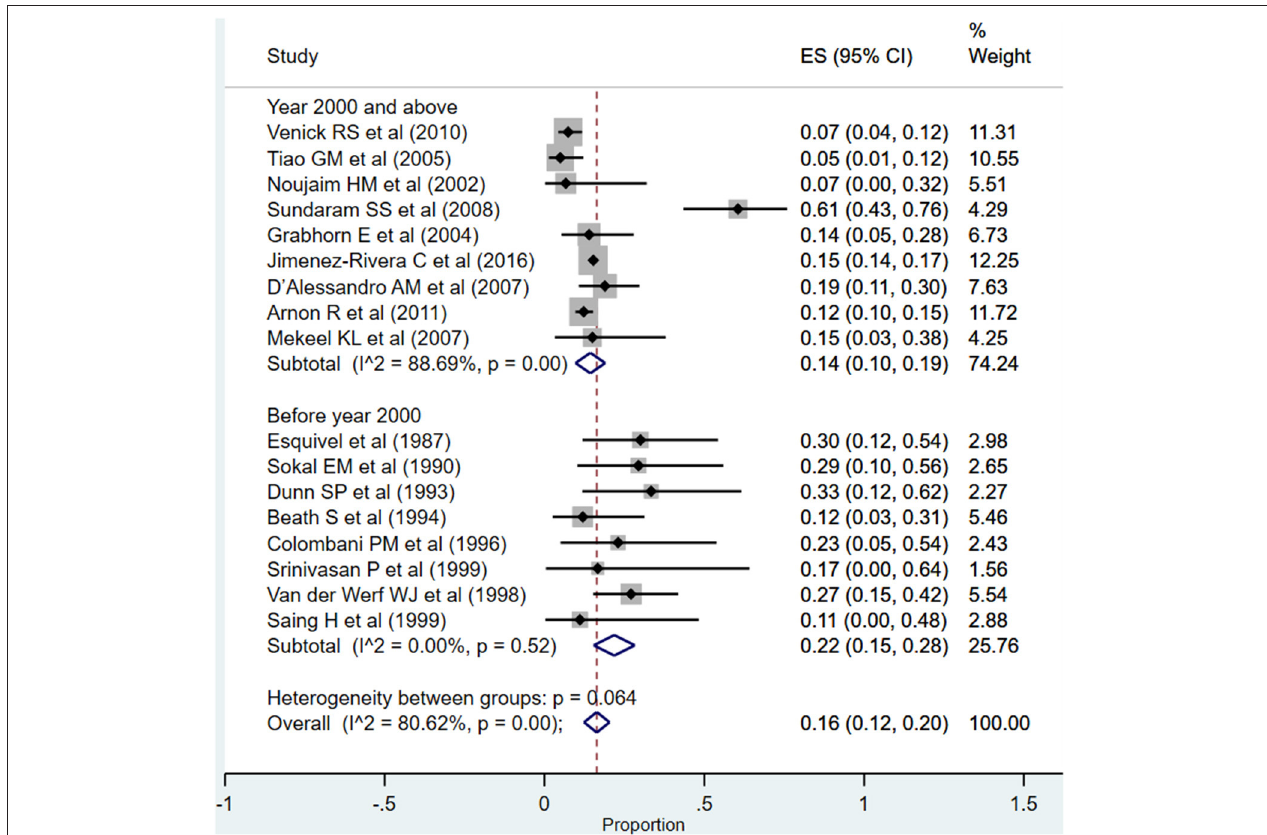
FIGURE 9 | Pooled rate for re-transplantation in the included